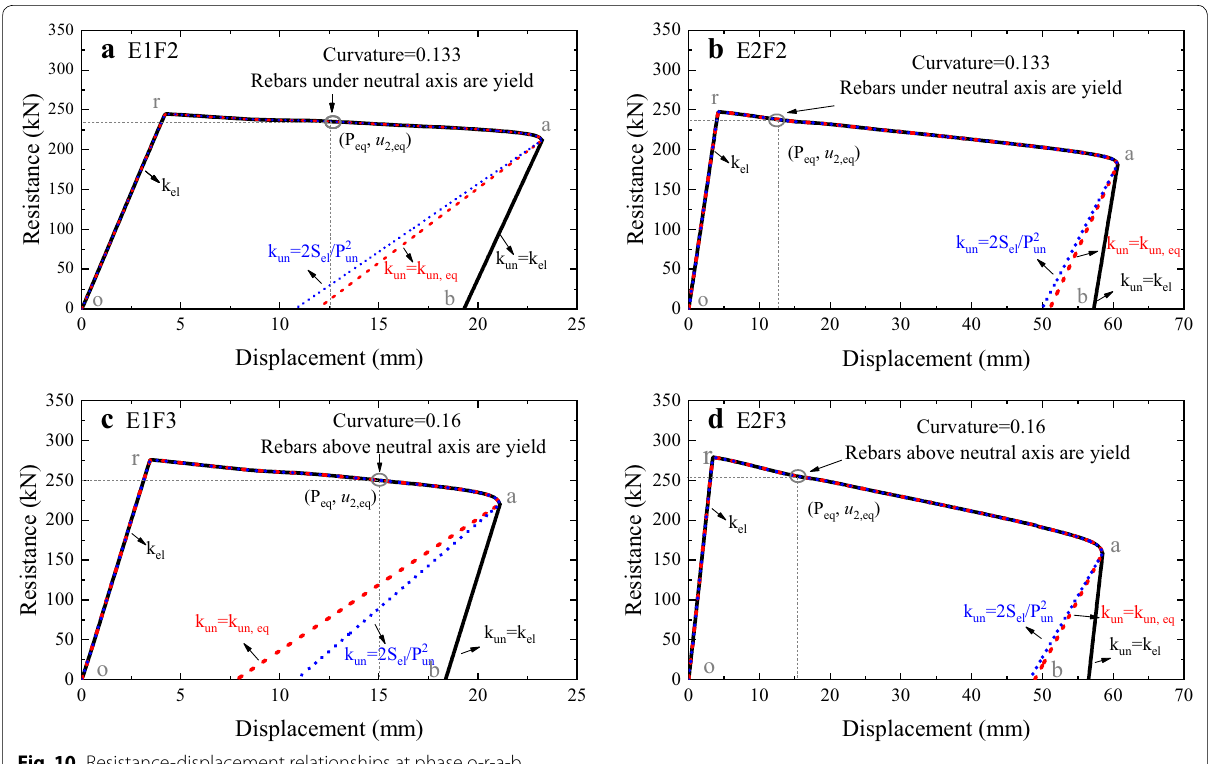
Fig. 10 Resistance-displacement relationships at phase